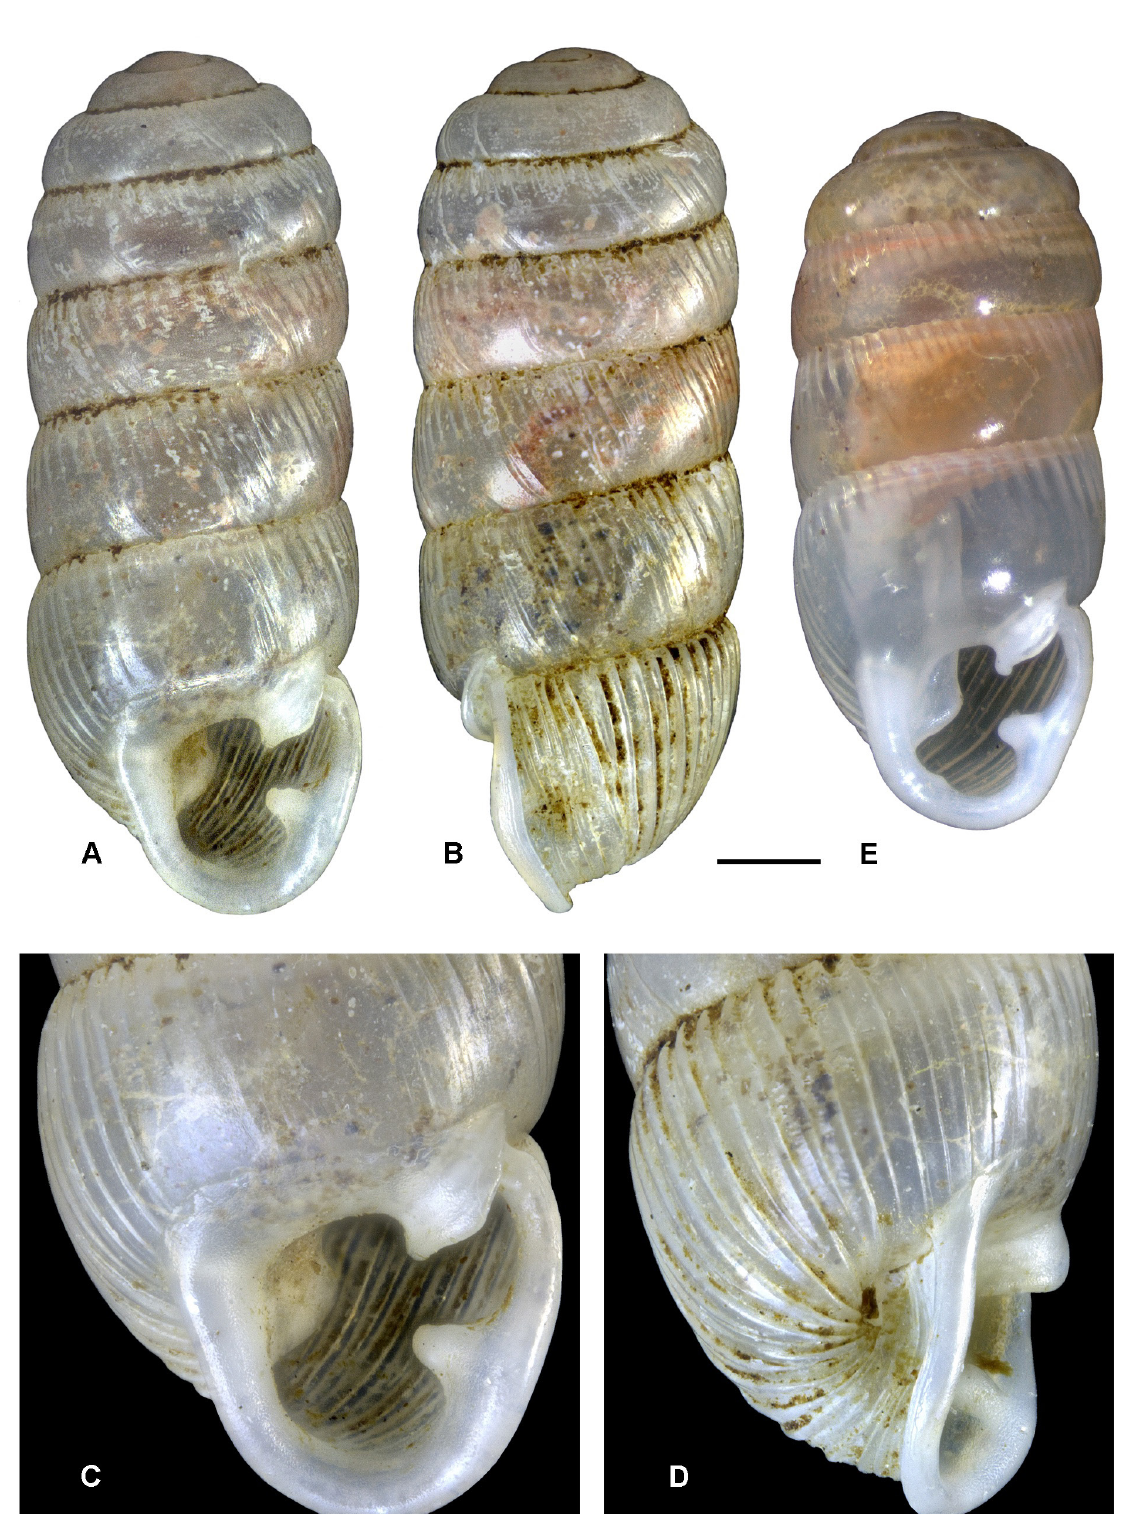
Fig. 11. Gulella maraisi sp. nov., holotype (NMSA P1676/T4520), length 4.12 mm, width 1.63 mm. A . Aperture view. B . Side view. C . View into aperture. D . Oblique view of base showing umbilicus. E . Specimen from Eastern Cape population (ELMD 18754), length 3.57 mm, width 1.55 mm. Scale bar = 0.5